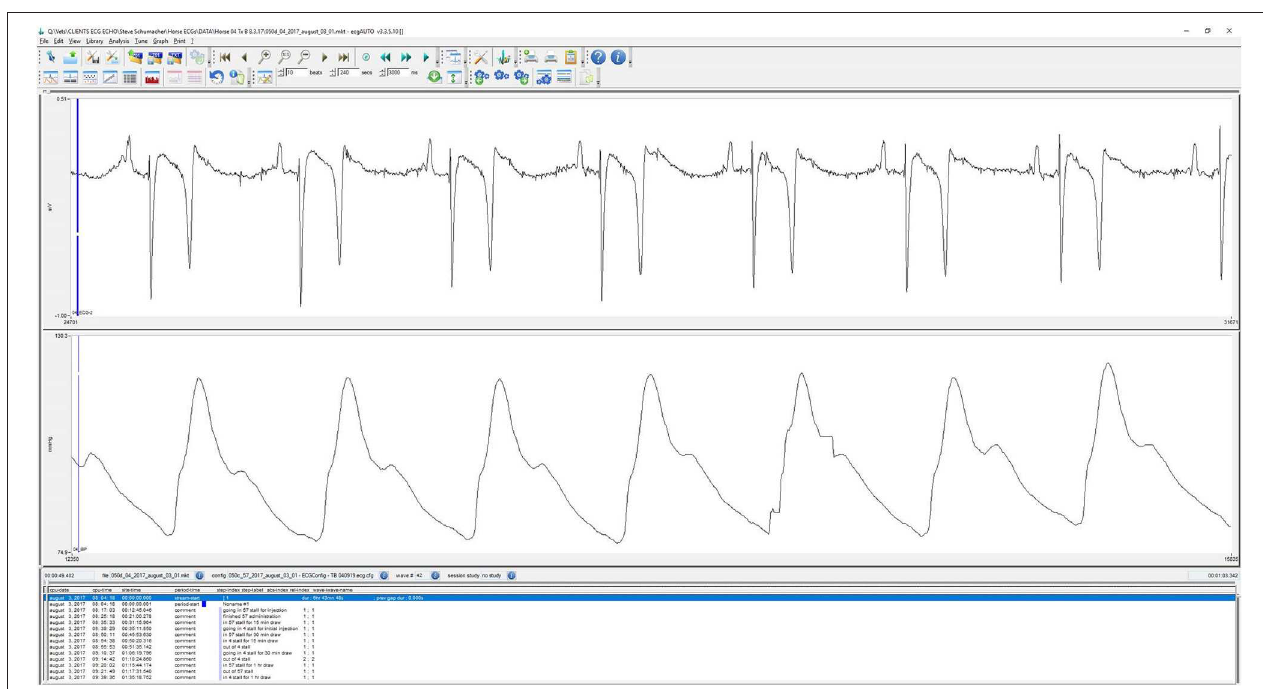
FIGURE 3 | Characteristic screen shot of ECG and arterial blood pressure waveform during wireless Bluetooth acquisition from a